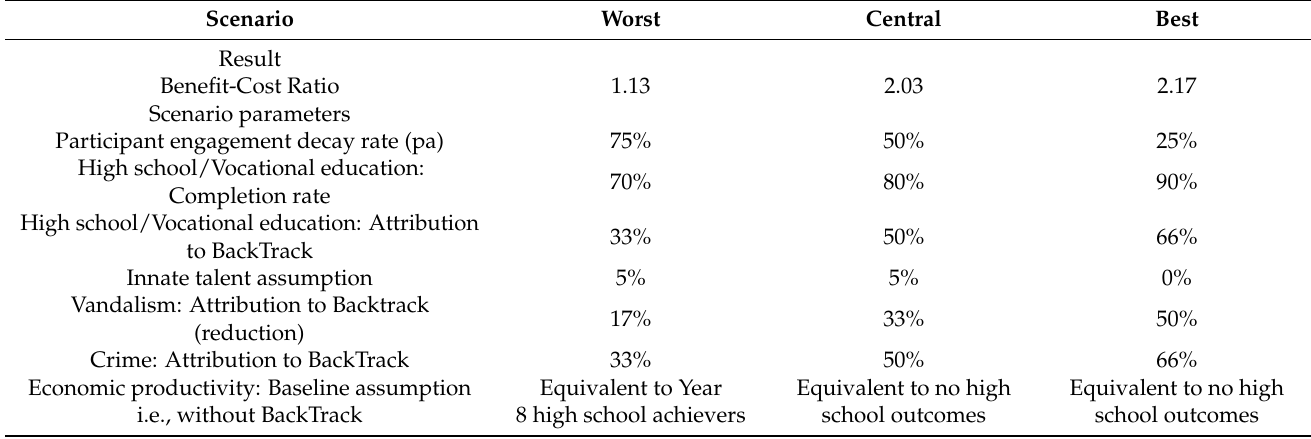
Table 3. Sensitivity analysis using variations in key parameters.